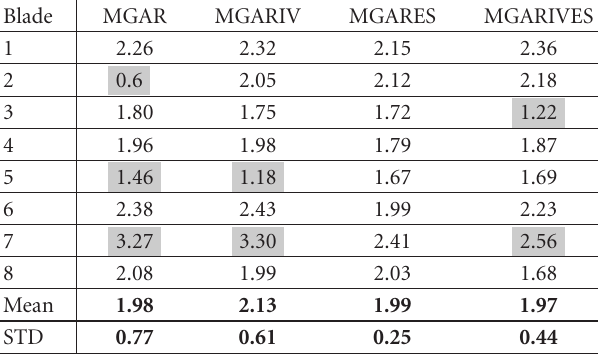
Table 5: 2EO and 8EO case: the first blade mode frequencies (Hz) recovered by BTT methods.